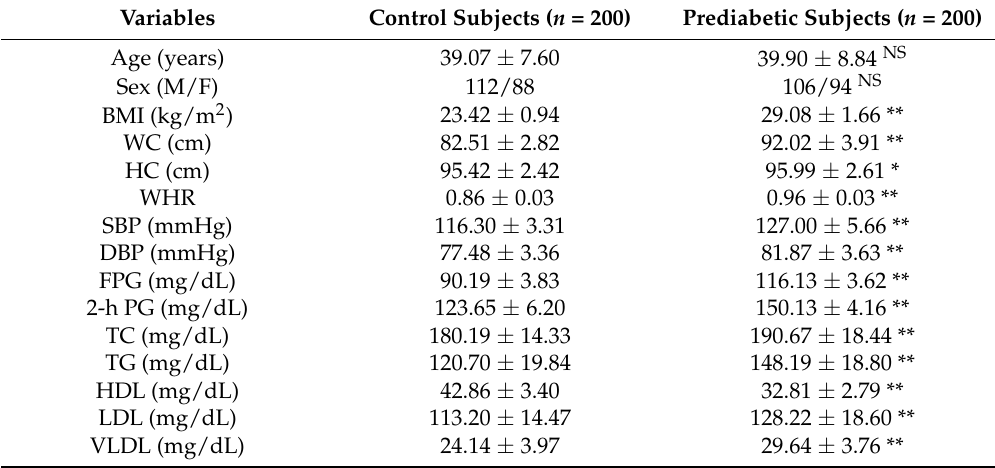
Table 1. Sociodemographic and biochemical characteristics of the studied subjects.